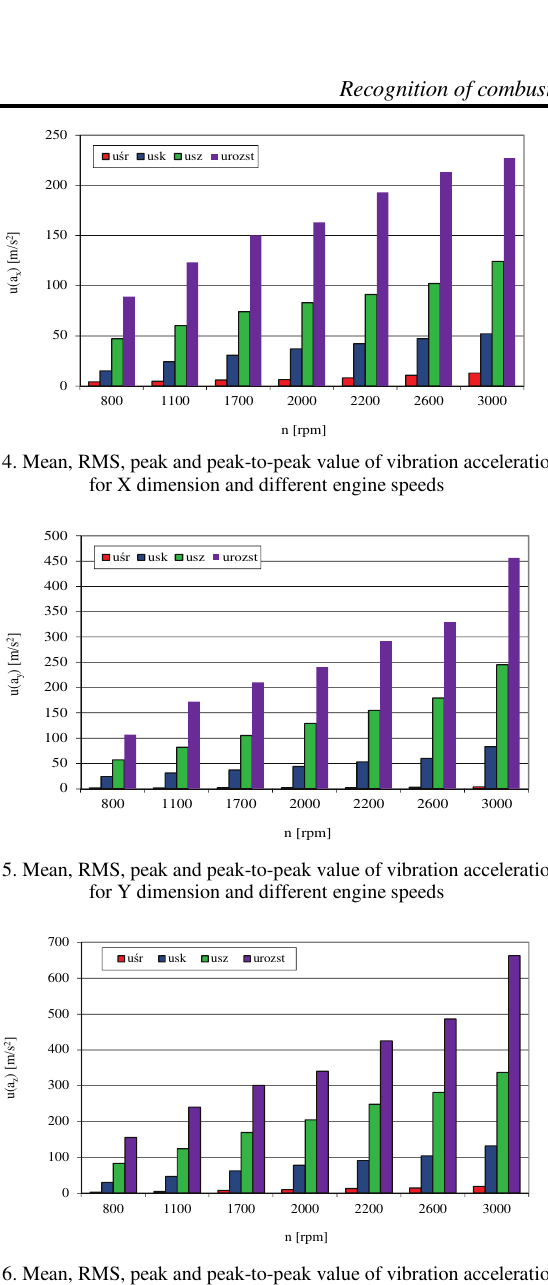
Fig. 6. Mean, RMS, peak and peak-to-peak value of vibration accelerations for Z dimension and different engine speeds